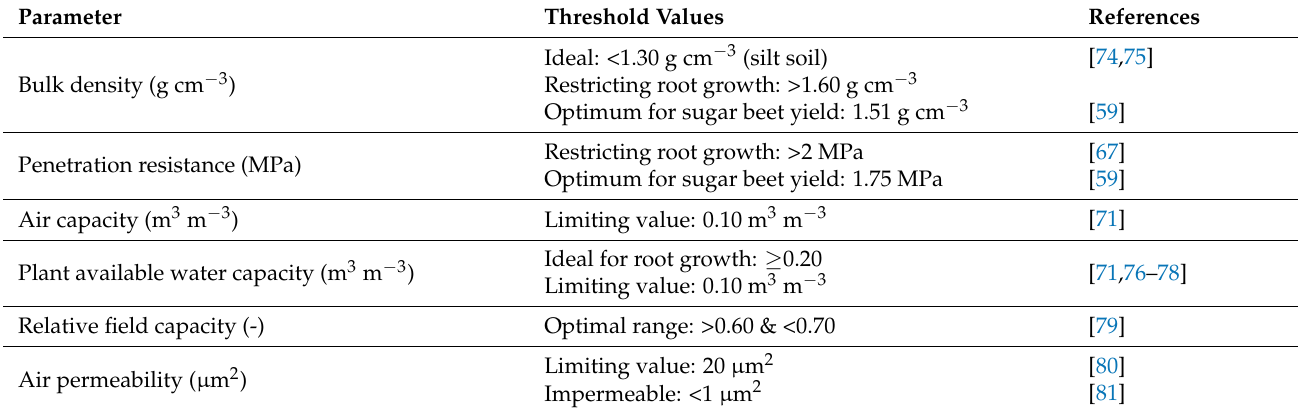
Table 3. Relevant threshold values for the investigated soil physical